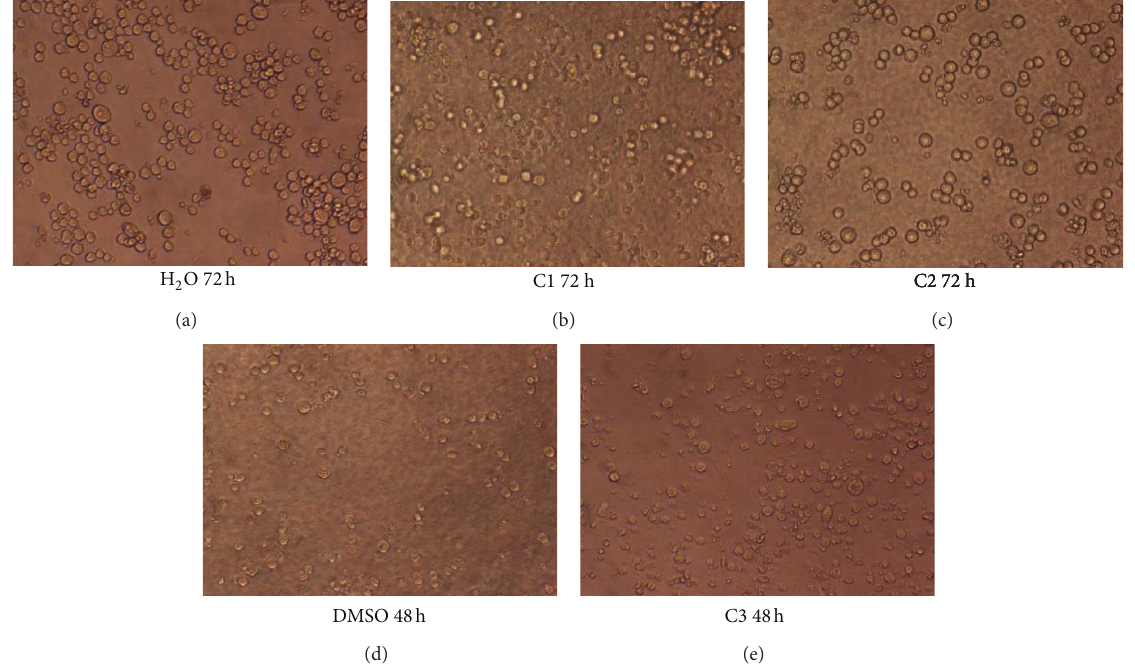
Figure 5: Microscope images (20x) of K562 cells with controls (H 2 O and DMSO) and IC 50 values of metal complexes for 48 and 72 hours. (a) Image of K562 cells at 72 h with distilled water as a control; (b) and (c) images of the cells at 72 h with IC 50 values of C1 and C2 complexes, respectively; (d) image of the cells at 48h, incubated with DMSO as a control of C3 complex; (e) image of the cells at 48 h, incubated with IC 50 value of C3.